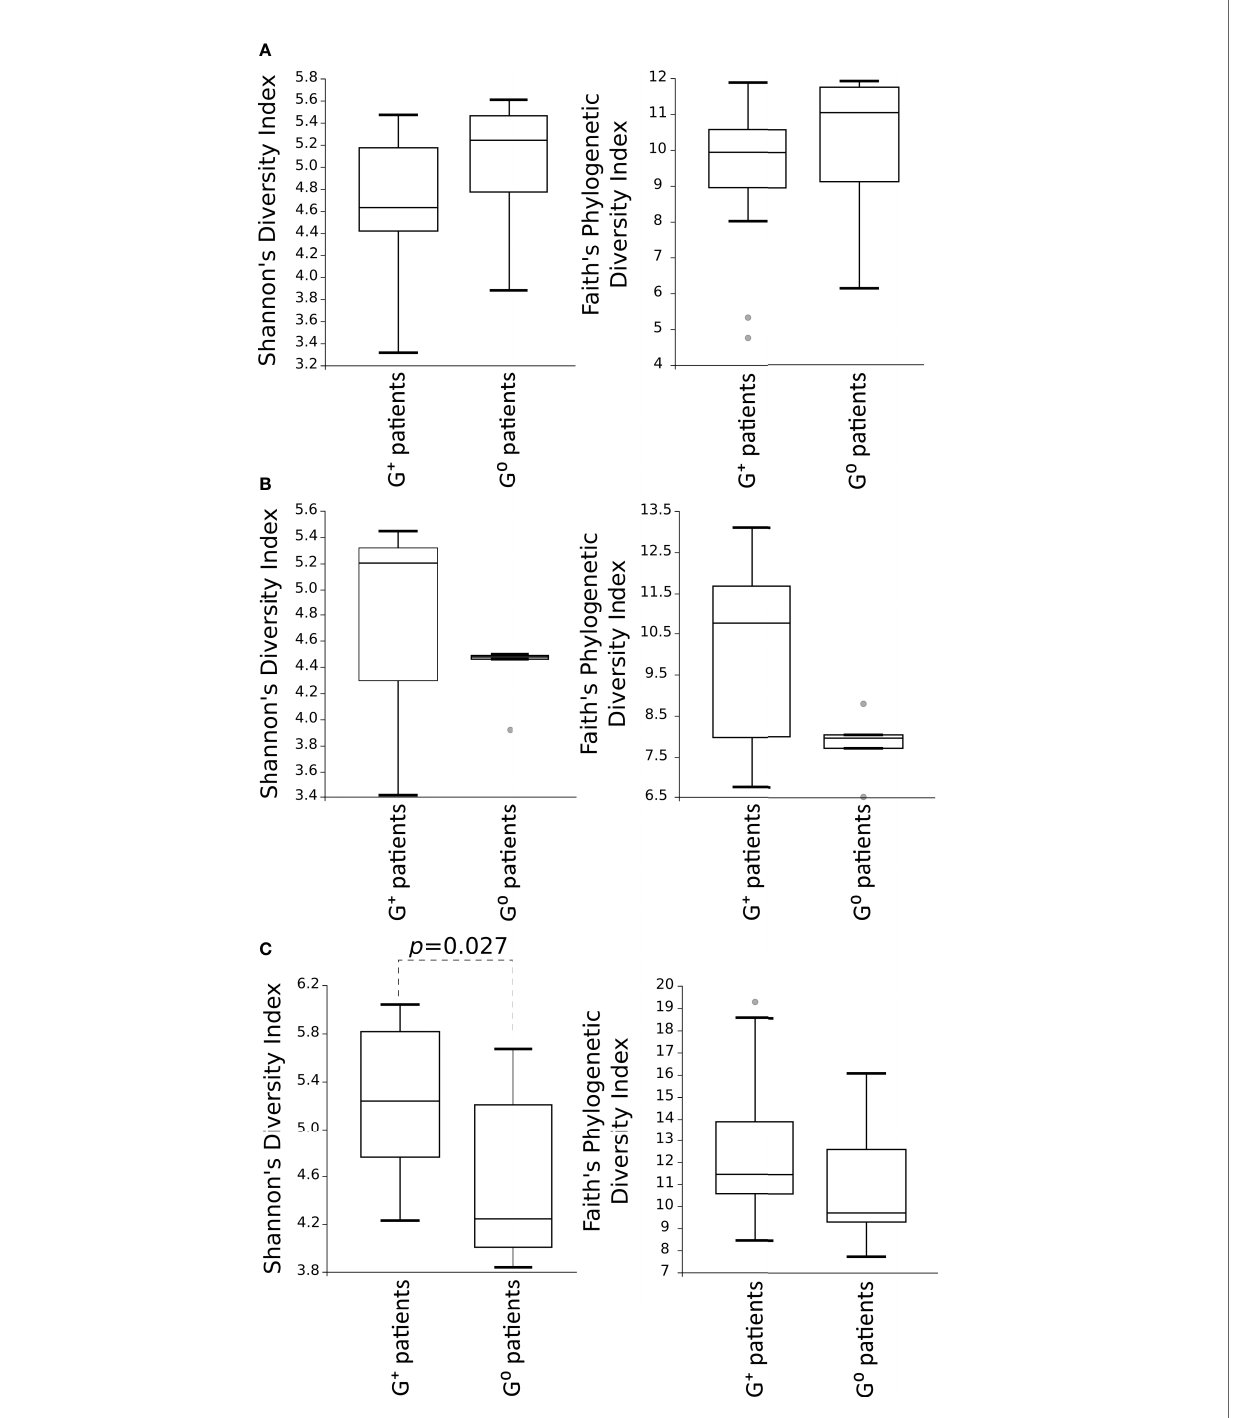
FIGURE 2 | Comparison of the alpha-diversity of the microbial communities between G + and G 0 patients. Microbiota from gastric (A) and duodenal (B) biopsies, as well as from faecal (C) samples, are represented. Shannon ’ s diversity and Faith ’ s phylogenetic diversity indexes were used as measure of alpha-diversity within groups. Samples were rare fi ed to the smallest observed number of reads (1257 for gastric biopsies, 931 for duodenal biopsies and 2935 for faecal samples). The circles out of the range represent the